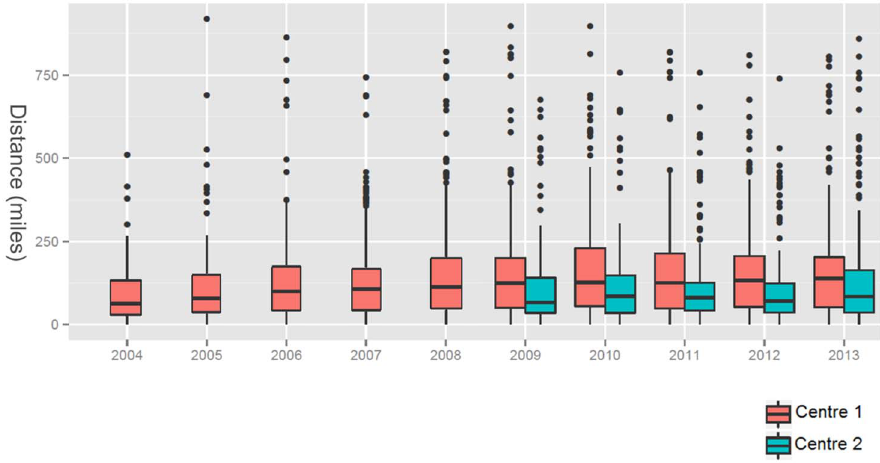
Figure 3. Mean airplane distance from the patients’ homes to the hospital. Foreign patients could not be included in the distance evaluation.